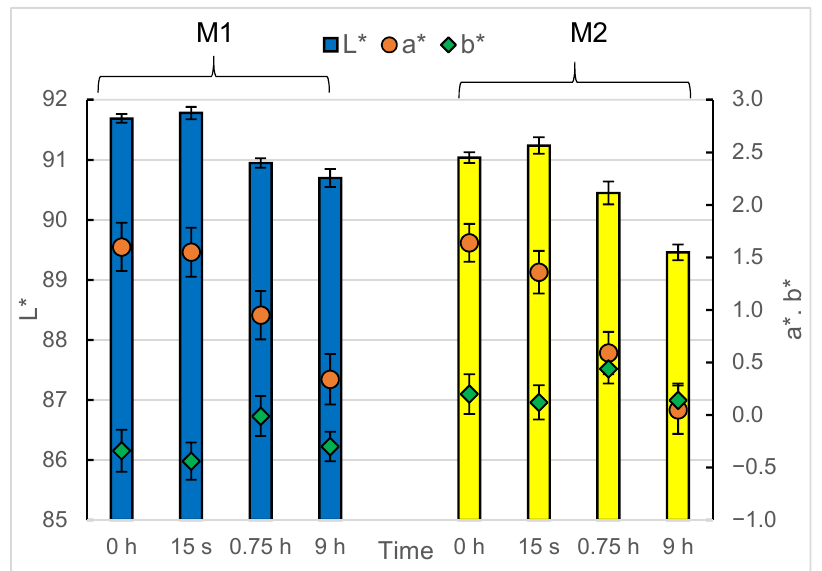
Figure 1. The plaque-staining agent-induced change in the experimental materials’ CIELAB parameters with the reaction time: L* (lightness) presented in the form of columns, a* (expression of the red-green wavelengths) presented in the form of filled, red circles; b* (expression of the yellow-blue wavelengths) presented in the form of filled, green diamonds. M1—the brackets, M2—the brackets with the adhesive material. Error bars express the experimental and analytical uncertainty calculated as a standard deviation of the replicates. The experiments were repeated 3 times, and the measurements were performed 10 times per sample. p < 0.05 was considered as the significant difference parameter.